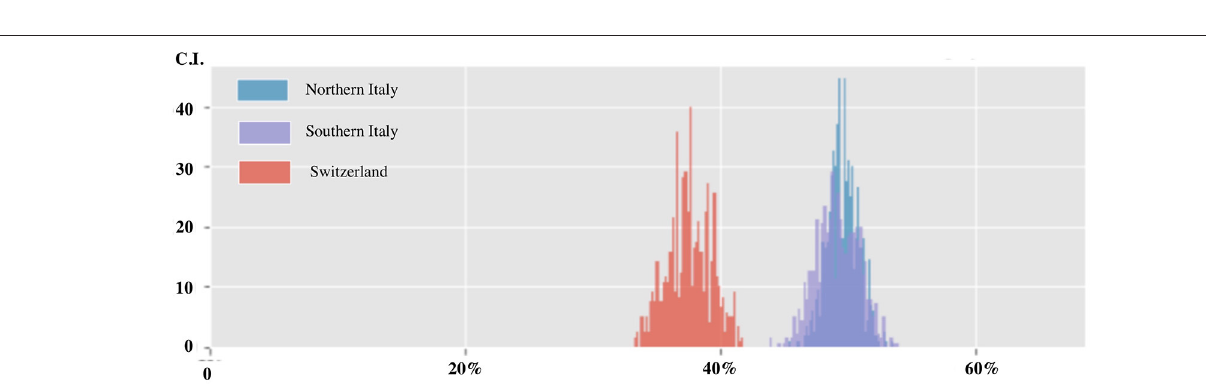
FIGURE 4 | Confidence in the future among healthcare workers divided by geographical region (Nothern Italy, Southern Italy and